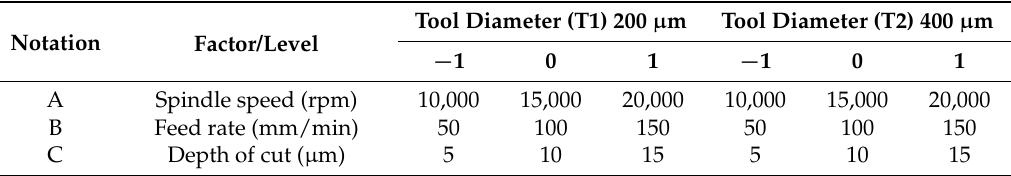
Table 1. Various levels of four factors, including spindle speed, feed rate, and depth of cut, used in the experiments.